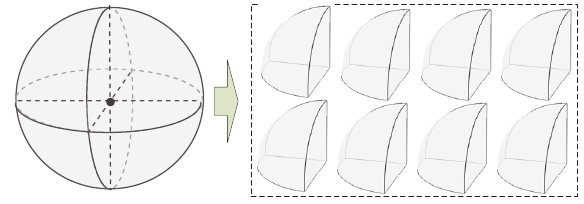
Figure 2 Dividing the reference spheroid into eight octants by equatorial plane, 0 o meridian plane and 90 o meridian plane.